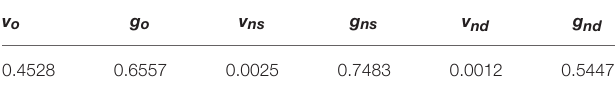
R 0.0963, ( v c , g c + ). = ∈